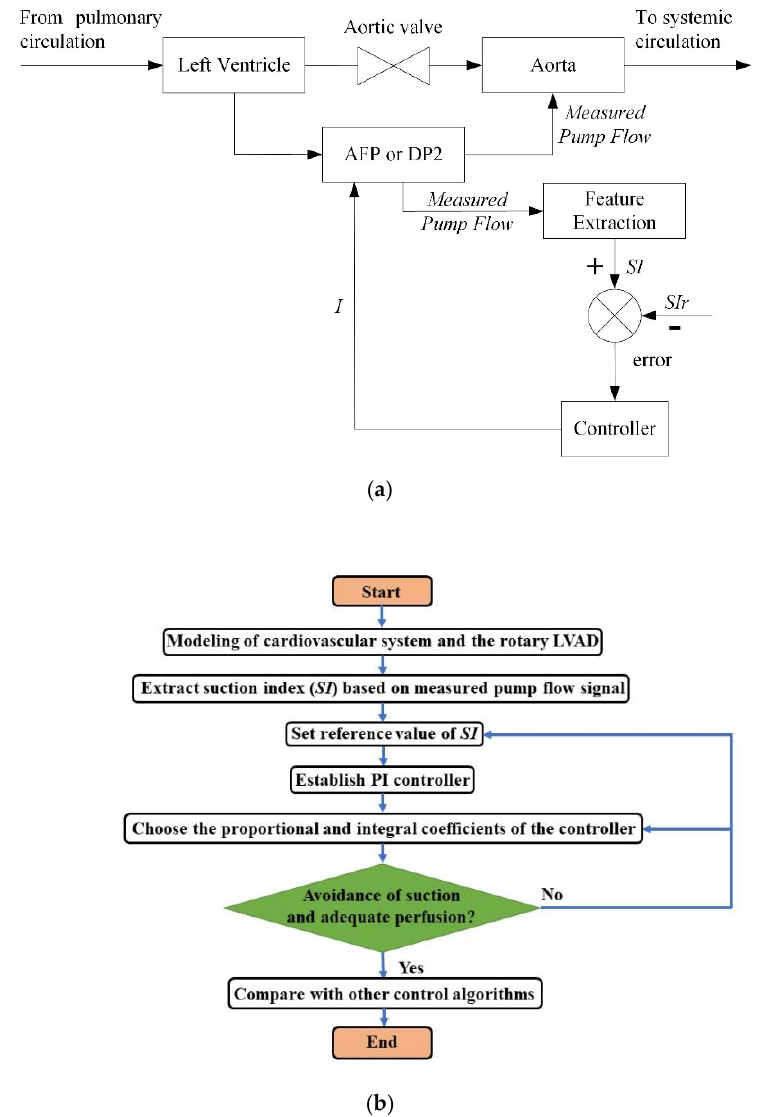
Figure 1. ( a ) Diagrammatic drawing of the proposed suction-index based measured pump flow (SIMPF) control algorithm. The measured pump flow (PF) signals were used to calculate suction index ( SI ) and fed to the PI controller with the reference SI ( SI r ) for axial flow pump (AFP) and Deltastream mixed flow pump (DP2), respectively, which were surgically implanted from the left ventricular to the aorta. ( b ) Flowchart of the proposed SI control method.